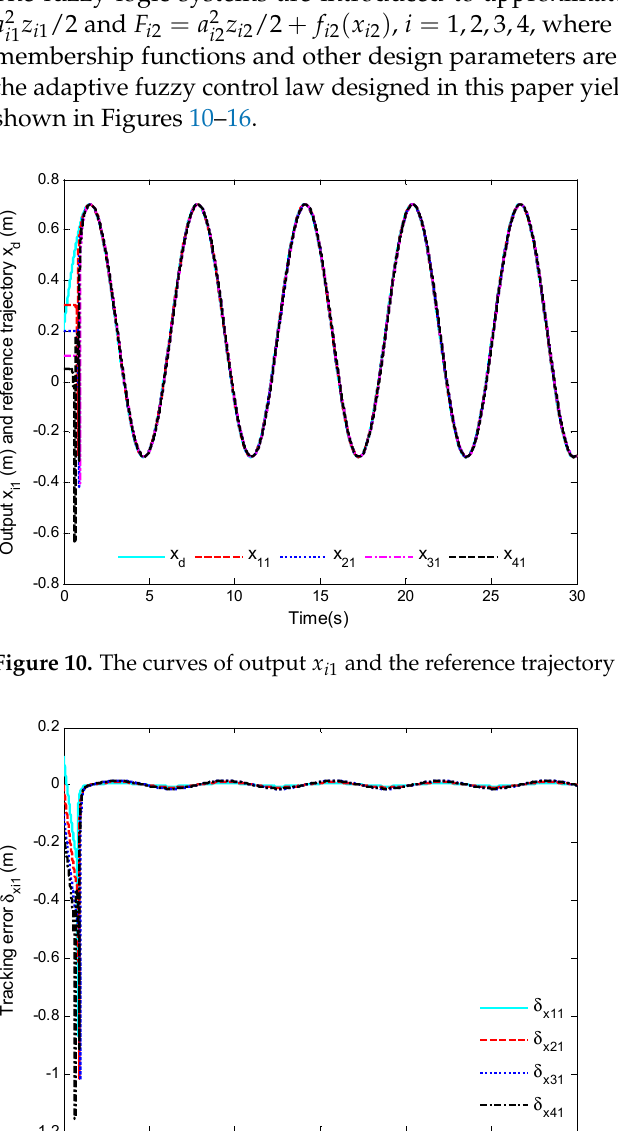
Figure 1. The model of a dead-zone fault is described as (2).